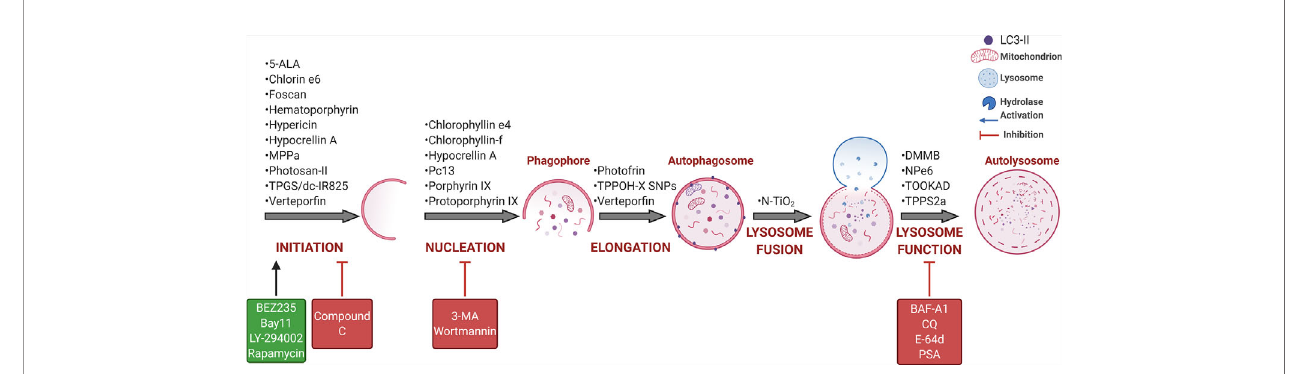
FIGURE 4 | PDT-mediated autophagy regulation in tumor cells. Several PSs were described as phototherapeutic modulators of autophagy fl ux, which may be further activated (green) or inhibited (red) by some drugs, including the Class I PI3K/mTOR inhibitor (BEZ235), NF k B inhibitor (bay11), pan-the Class I PI3K inhibitor (LY-294002), or mTORC1 inhibitor (rapamycin), AMPK inhibitor (compound C), Class III PI3K/VPS34 inhibitor (3-MA or wortmannin) and lysosome inhibitor (BAF-A1, CQ, E-64d, or PSA) (104, 150 – 156). BAF-A1 also blocks the lysosome fusion with autophagosomes that occurs independently on intralysosomal pH and relates to reduced ATP2A/SERCA activity (152, 157). For more details, see Tables 1 and 2 . Art was created with